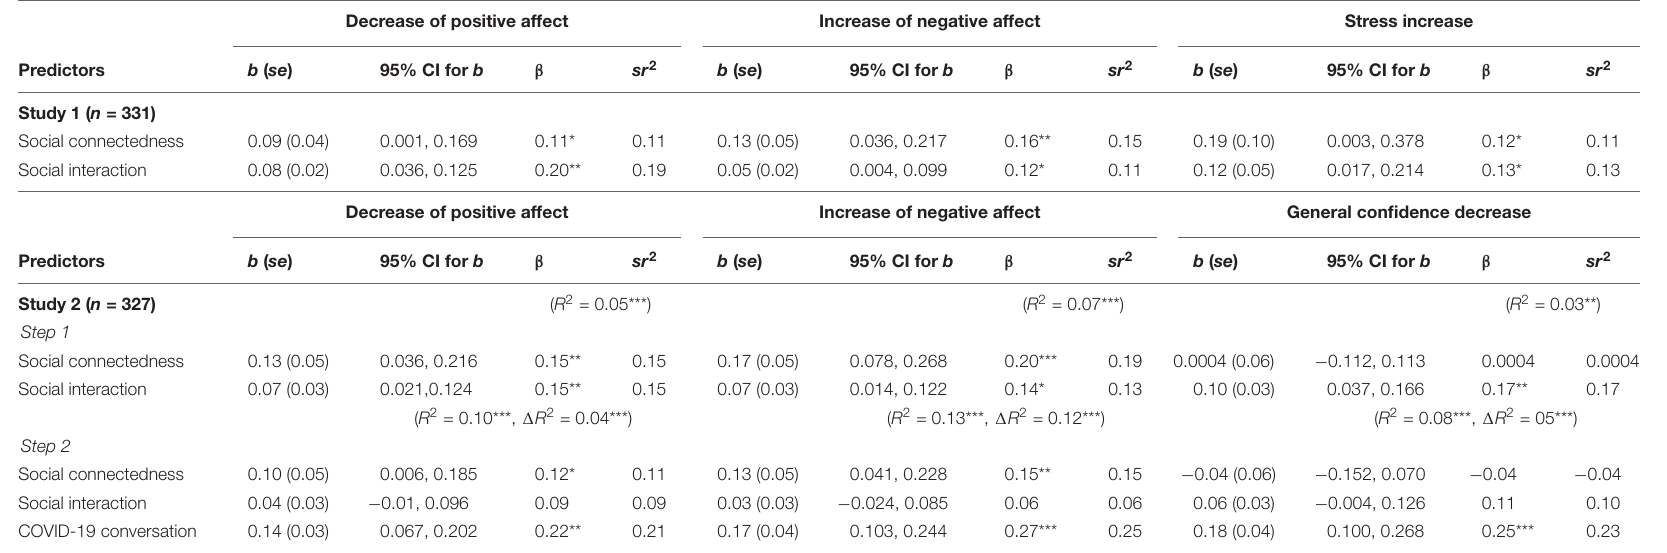
decreased general